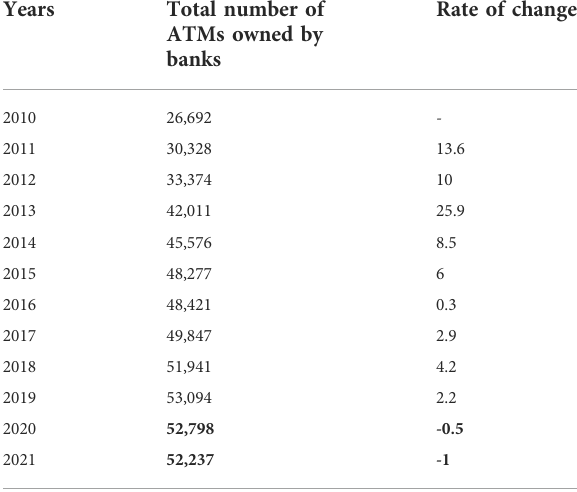
TABLE 9 Total number of ATMs owned by banks during 2010 –